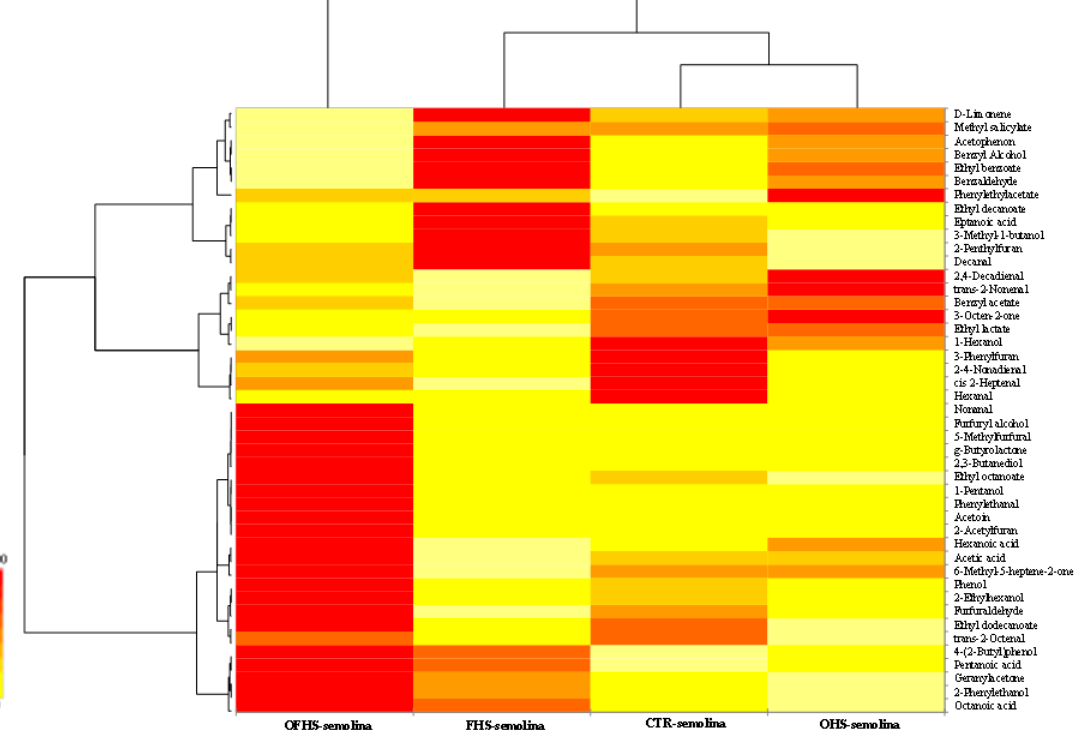
Figure 5. Distribution of the volatile organic compounds among the pizza samples from the different trials. The double hierarchical dendrogram is based on the values of the volatile organic compounds (VOCs). The heat map plot depicts the relative percentage of each compound within each pizza.